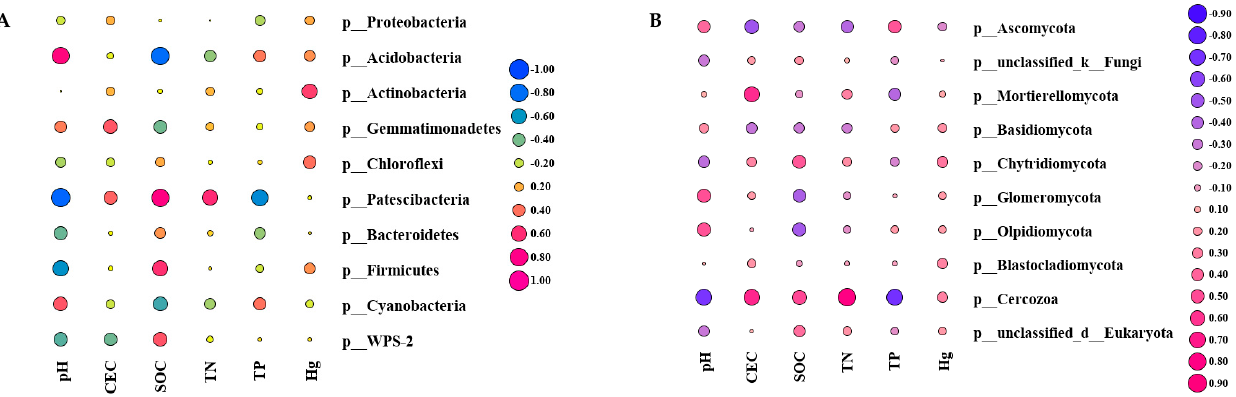
Figure 7. Pearson correlation analysis between the relative abundance of dominant soil microbial phyla and soil physicochemical and mercury content among different treatments. The value of the Pearson correlation coefficient is represented by the color of each circle. Pink indicates positive correlation; blue indicates negative correlation: ( A ) bacteria; ( B ) fungi.